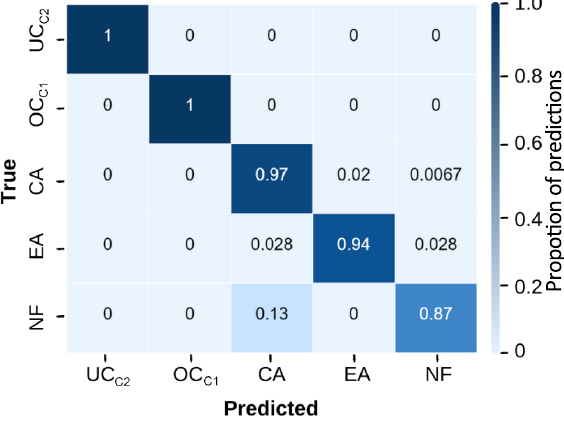
Fig. 8 Normalized confusion matrix for Method 3.